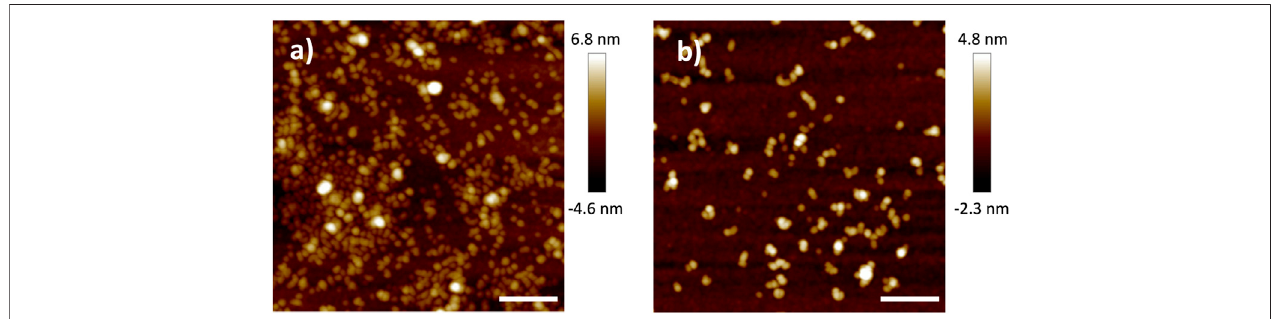
FIGURE 3 | (A) Distribution of Young ’ s modulus measurements by nano-indentation with AFM for i) HB-68nm-1k and ii) HB-106nm-1k-10k. (B) AFM topology scans ofthe HB-106nm-1k-10k fi lm deposited from concentrated (10 g/L) HB PEO solution in acetonitrile. The scale bar is200 nm. (C) Measured Young ’ s modulus ( E ) of HB-68nm-1k and HB-106nm-1k-10k fi lms by nano-indentation with AFM, which was averaged over 100 force curve measurements shown in (B) . The error bars represent one standard deviation from the mean.